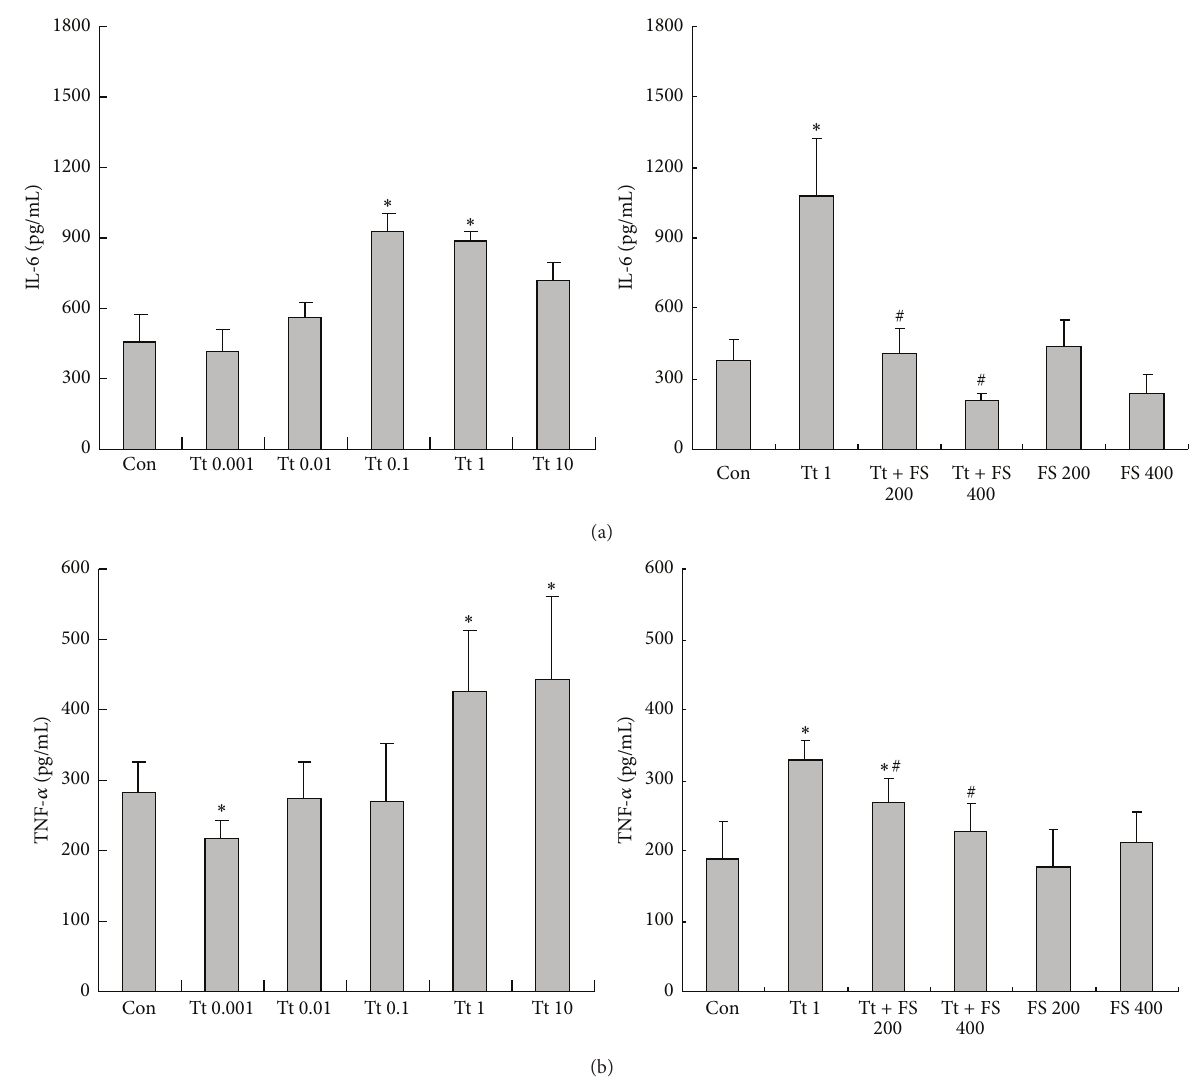
Figure 3: Effects of tryptase (Tt) on the secretion of IL-6 (a) and TNF- 𝛼 (b) from astrocytes. Astrocytes were exposed to different concentrations of tryptase (0.001, 0.01, 0.1, 1, and 10 𝜇 g/mL) in the presence or absence of FSLLRY-NH2 (FS, 200 or 400 𝜇 M), an antagonist of tryptase at 37 ∘ C for 24h before culture supernatant being collected. Data are presented as the mean ± SEM of four independent experiments. ∗ 𝑃 < 0.05 versus control groups (Con), # 𝑃 < 0.05 versus corresponding tryptase treatment